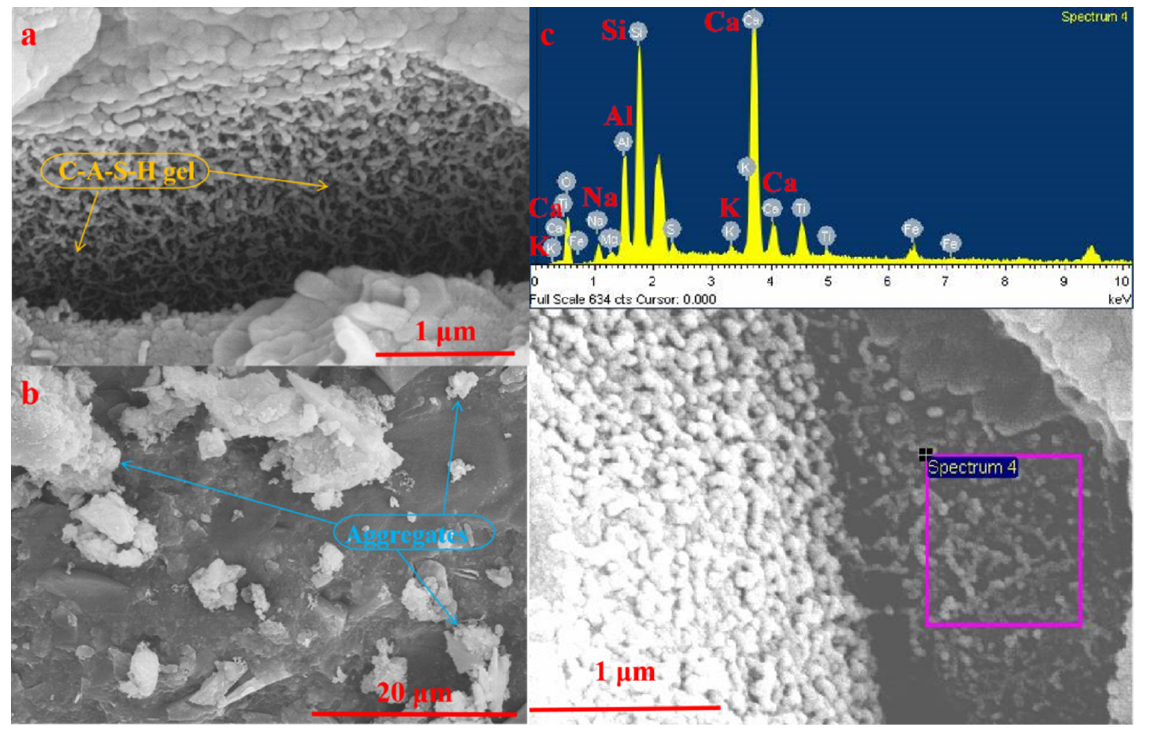
Figure 6. SEM morphology ( a , b ) and EDS analysis ( c ) of C-A-S-H gels in the AACM after 28 days of hydration.